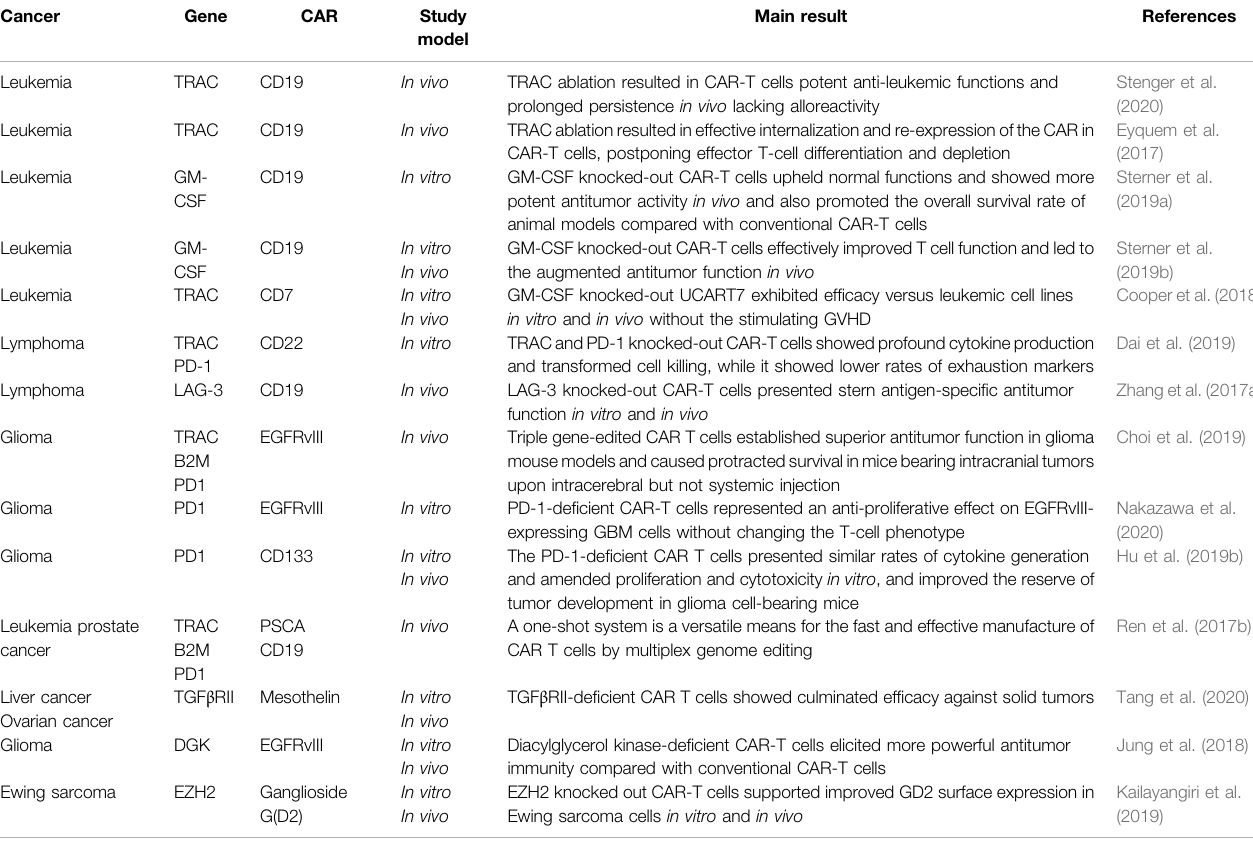
TABLE 2 | Overview of the application of CRISPR/Cas9 to generate universal-CAR T cells.